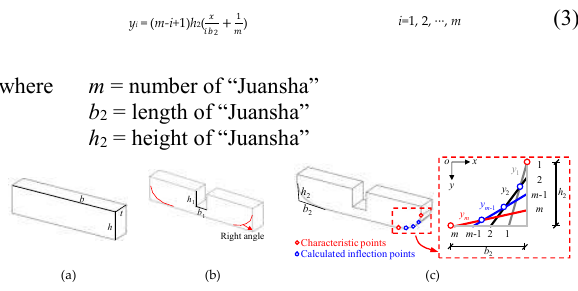
Figure 9. Schematic diagram of parameters of multi-LoD